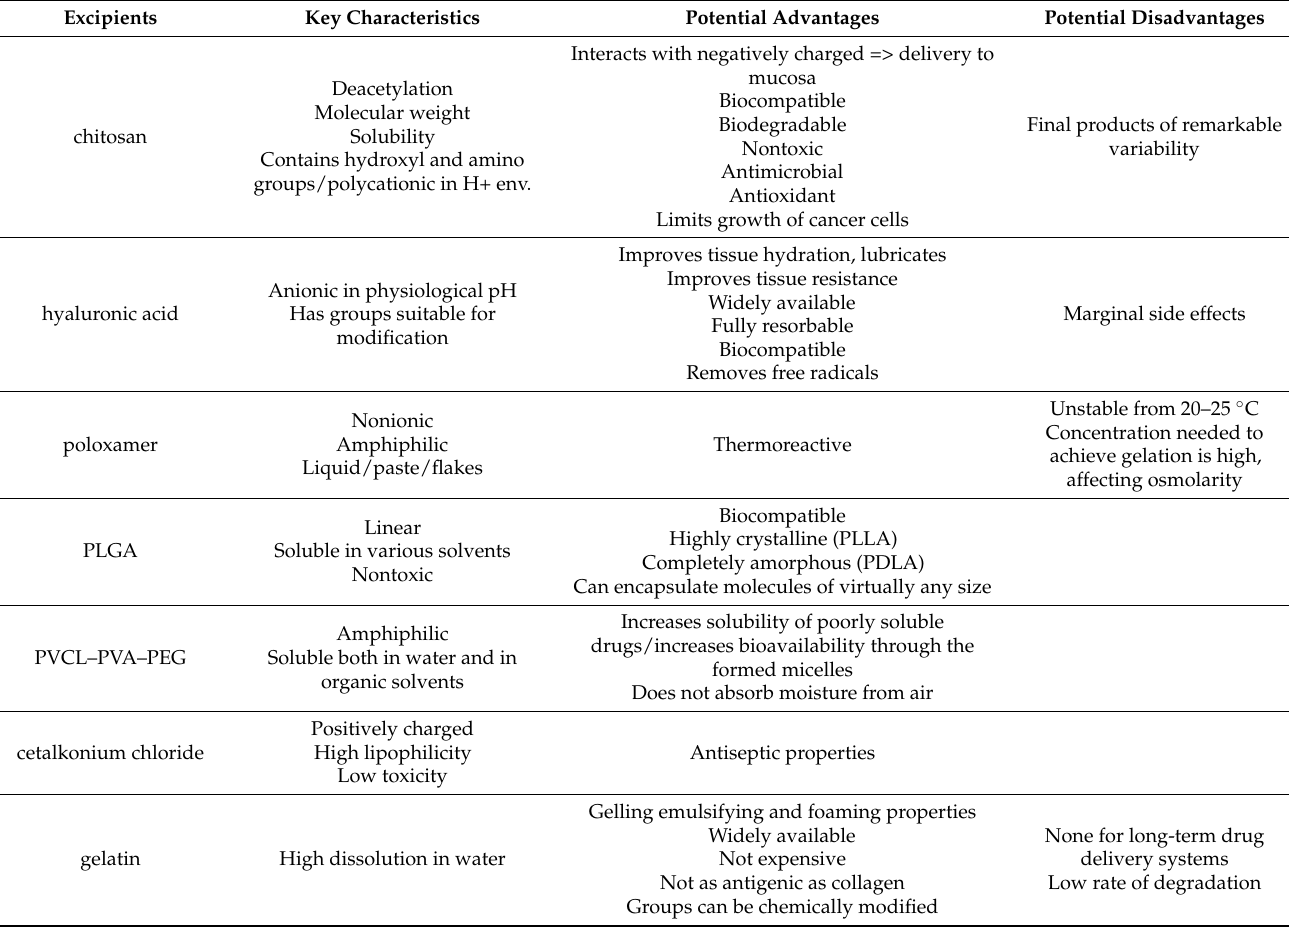
Table 5. Key characteristics of excipients and their potential advantages/disadvantages [161,162].